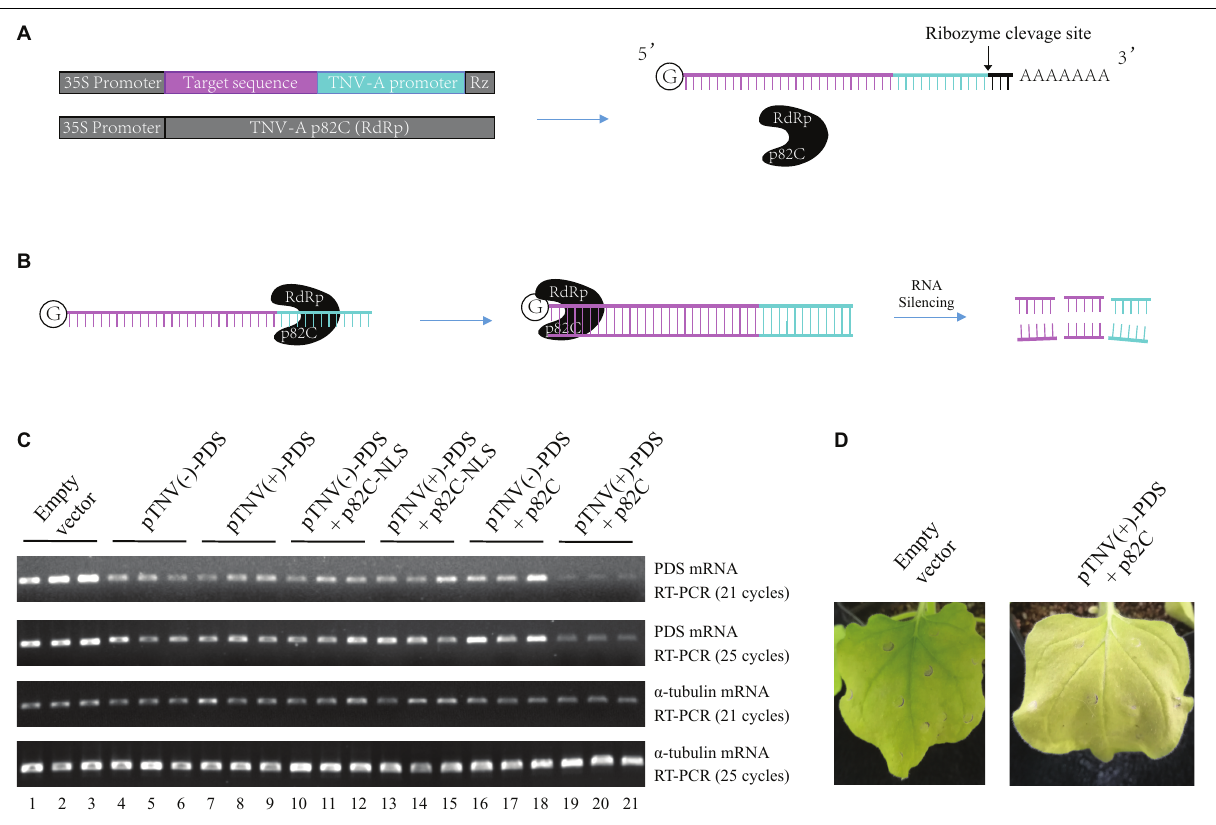
albino phenotype, suggesting successful silencing of the PDS gene ( Figure 1D